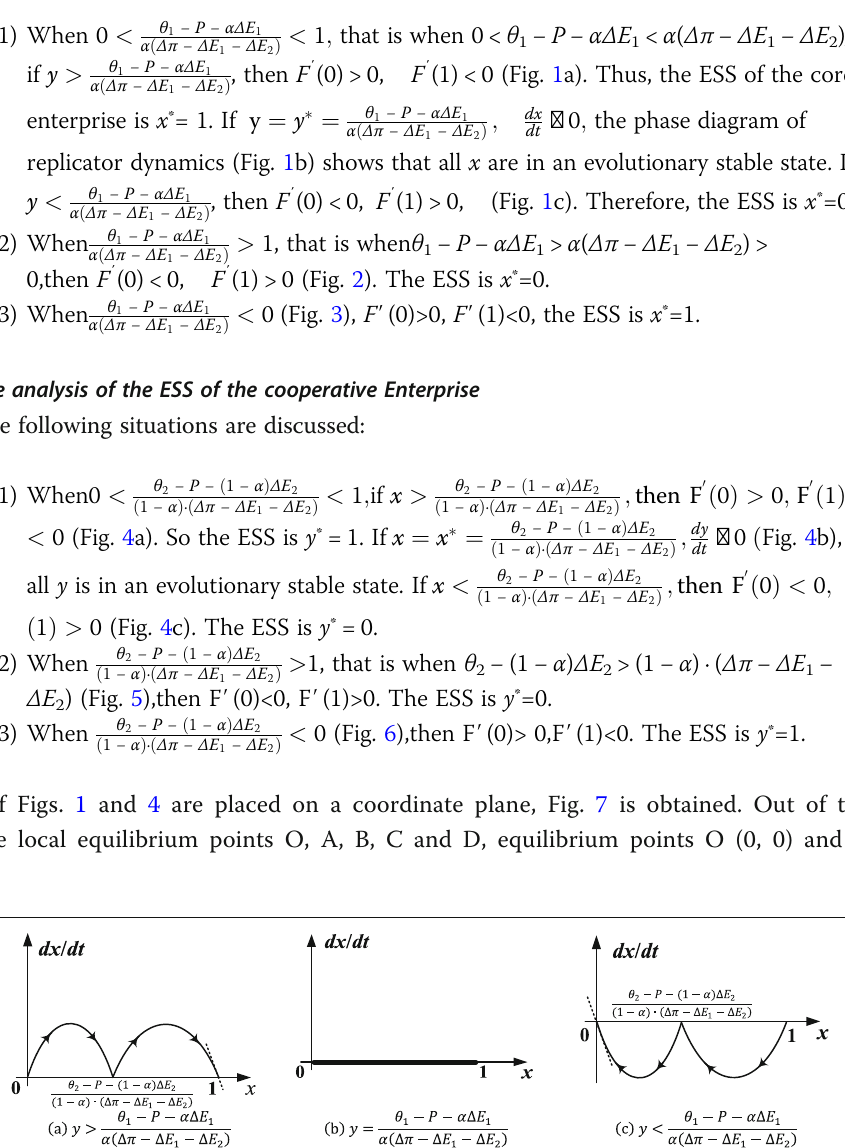
< ð Δ π − Δ E 1 − Δ E 2 Þ